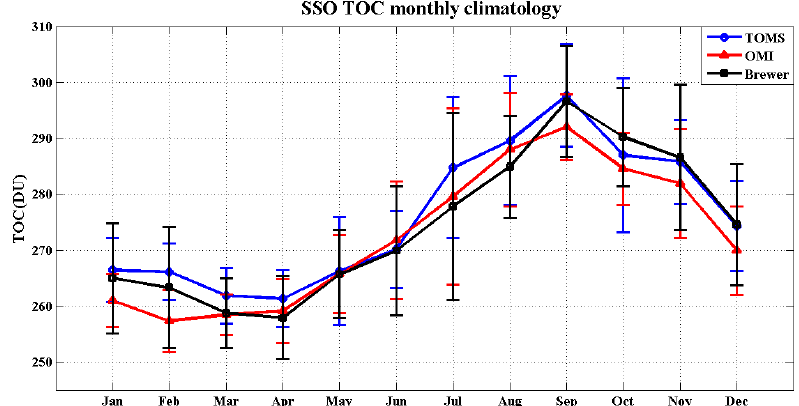
Figure 4. TOC monthly climatology means for the period between 1992 and 2014 by Brewer spectrophotometer (black) and TOMS (blue) and OMI (red) satellite instruments over Southern Space Observatory (SSO)